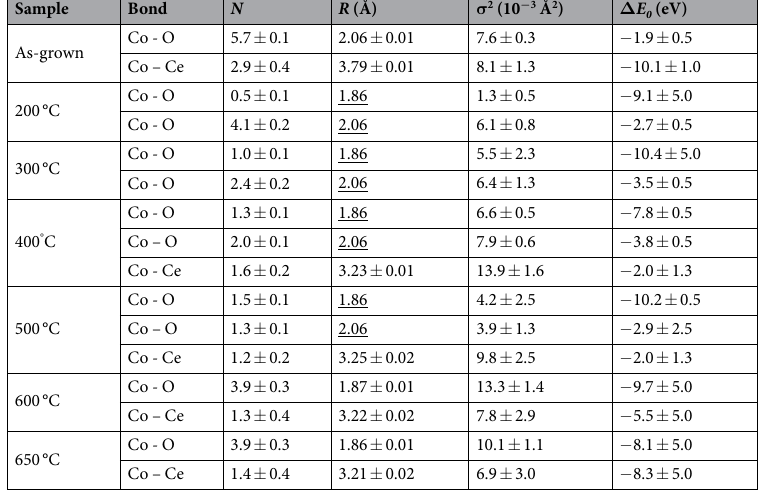
Table 1. Parameters of local structure around Co atoms obtained from curve-fitting of the Co K-edge EXAFS. N is the coordination number. R is the bond length. σ 2 is the Debye-Waller-like factor serving as a measure of local disorder. Δ E 0 is the difference between the zero kinetic energy value of the sample and that of the theoretical model used in FEFF. Uncertainties were estimated by the double-minimum residue (2 χ 2 )